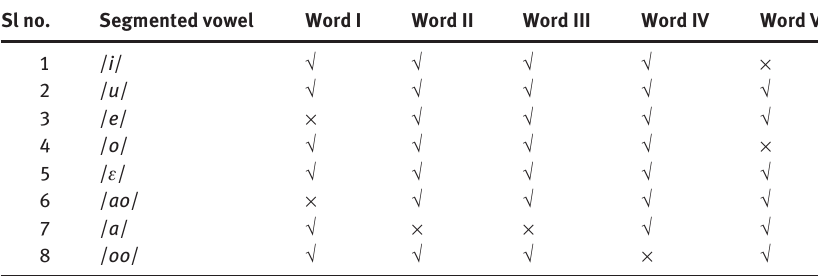
Table 8. Correct Identification of Boy Speaker